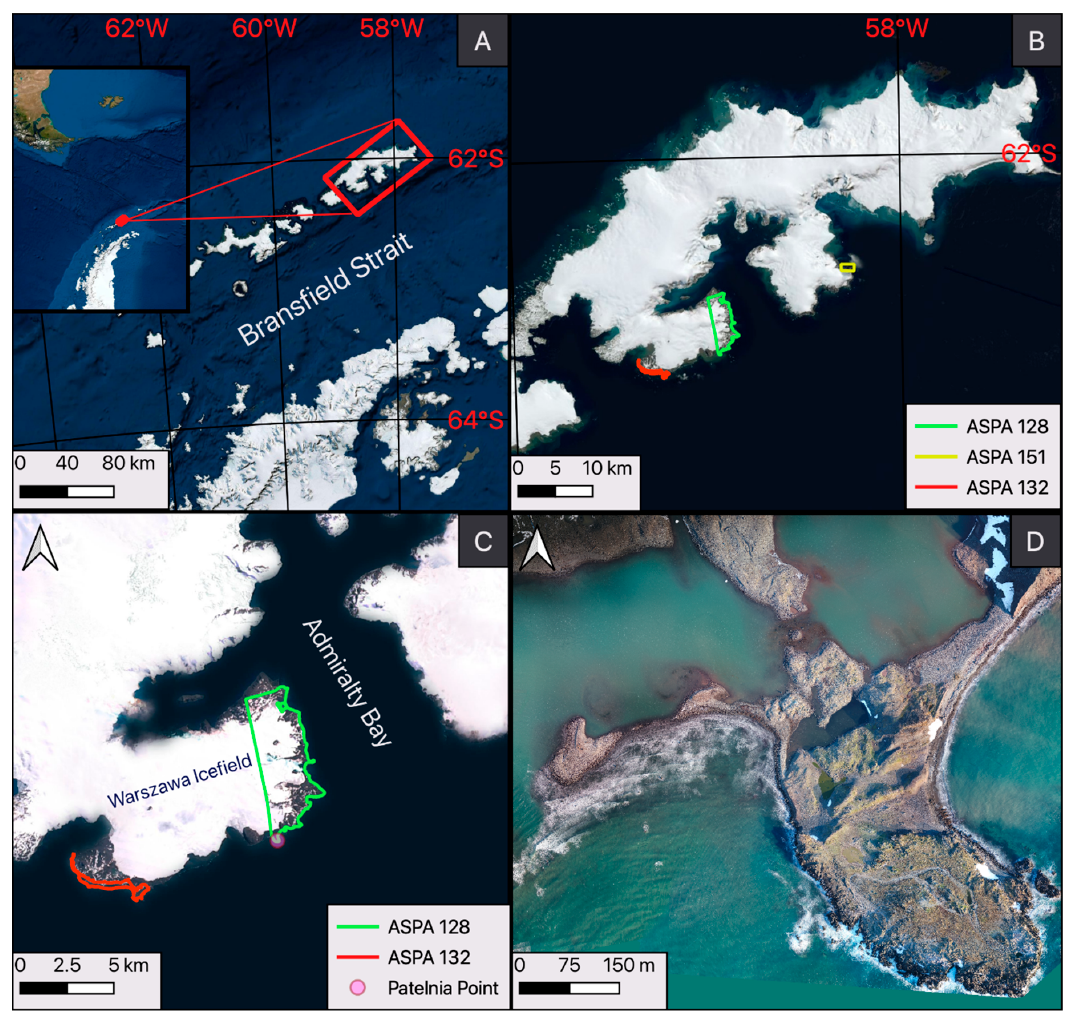
Figure 1. Location of the study areas: ( A ) Antarctic Peninsula; ( B ) King George Island; ( C ) western shore of Admiralty Bay; and ( D ) Patelnia Point.